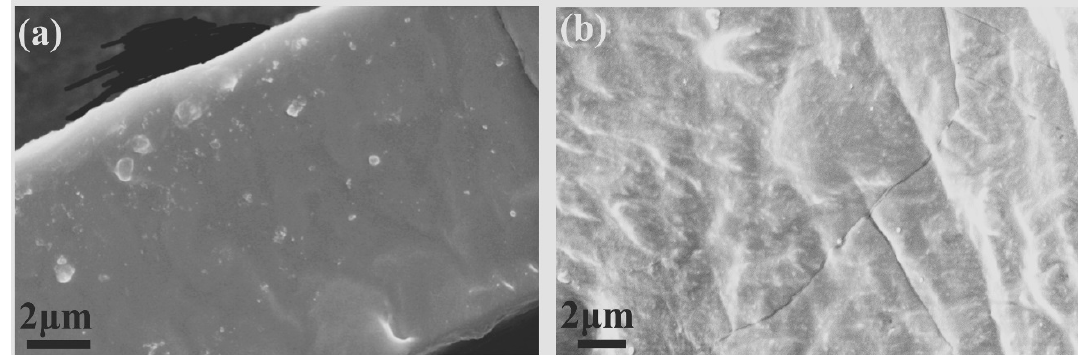
Figure 4. SEM images of ( a ) the pristine matrix and ( b ) the hybrid with 30 wt % PDMS-NH 2 .